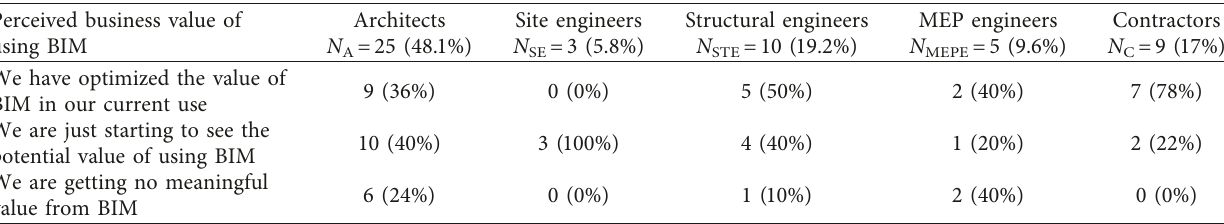
Table 2: Relationship between the role of the respondent and their company’s perceived current business value of using BIM. Perceived business value of